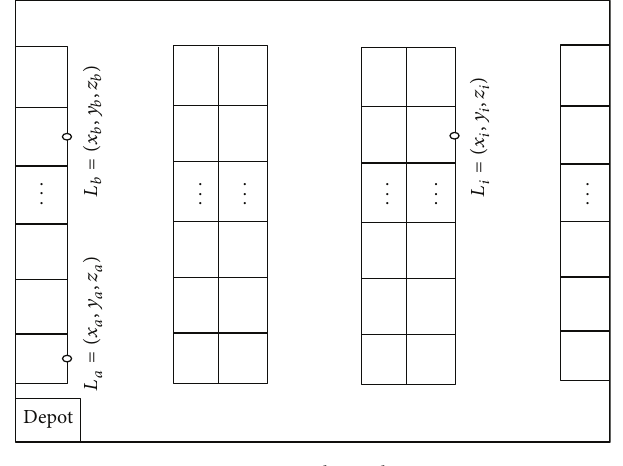
Figure 1: Warehouse layout.